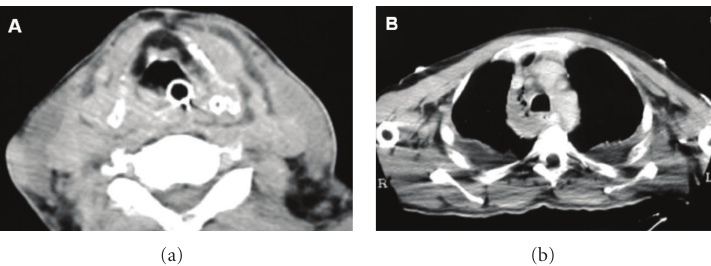
Figure 1: Patient number 1—CT images. (a) Area of e ff usion of liquid mixed with gas is visible between muscle planes in the cervical area.